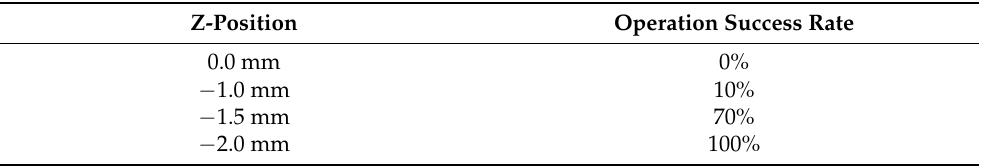
Table 6. Experimental results of the predictive process adjustment by controlling the z-position of suction start with box type